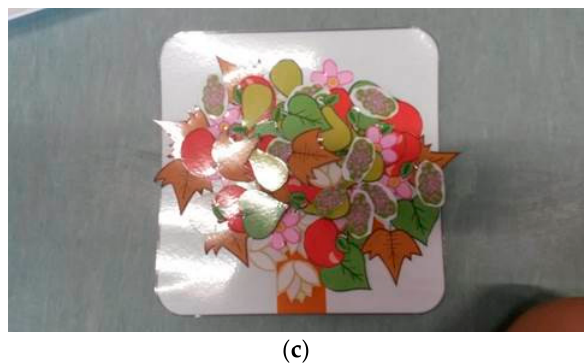
Figure 3. Beautiful is ( a ) Use all elements; ( b ) Aesthetic criterion (“These flowers are beautiful”); ( c ) Do not leave white space.